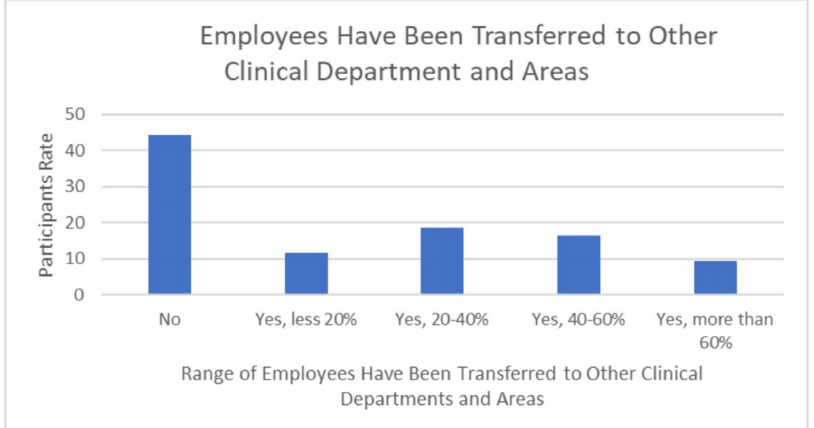
Figure 6. Radiology workers transferred to other clinics or